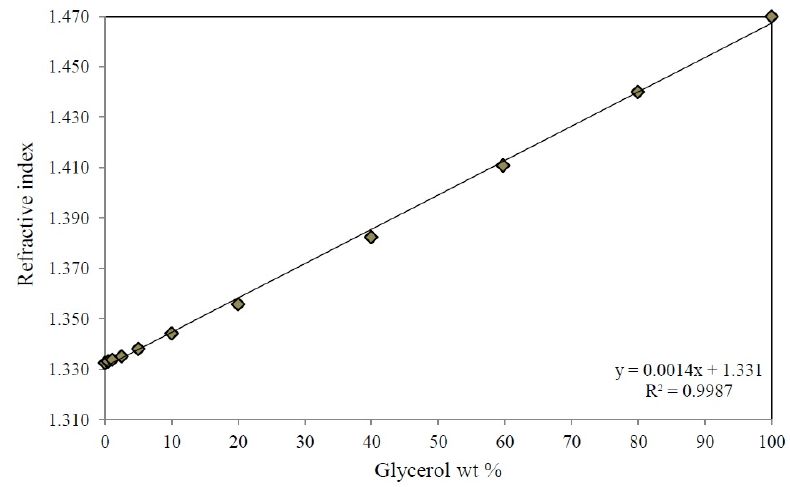
Figure A2. Calibration curve of refractive index of glycerol-water mixtures at 298 K.